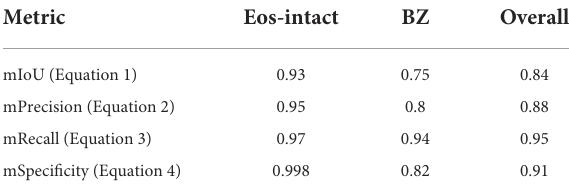
TABLE 1 Four segmentation metrics measured at the pixel level.